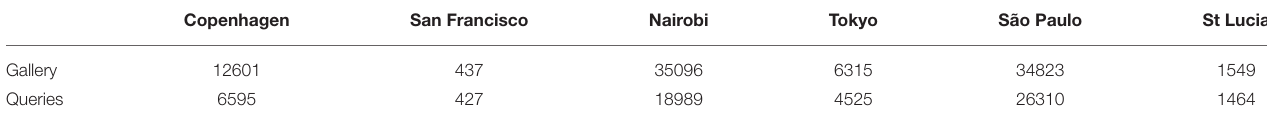
TABLE 2 | Sizes of cities from MSLS (Warburg et al., 2020) and St Lucia (Milford and Wyeth, 2008)